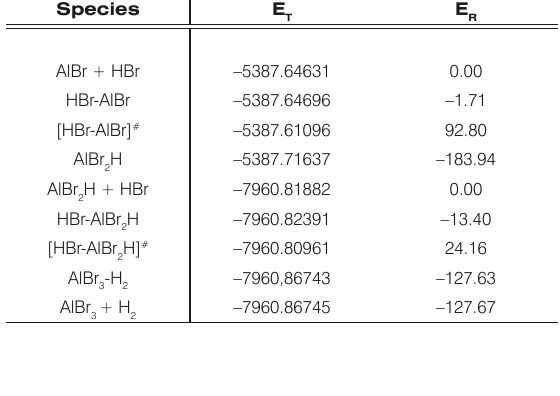
Table 1. CCSD(T)/6-311G(d,p)//B3LYP/6-311G(d,p) + ZPE Total Energies E (a.u.) and relative energies ER (kJ mol -1 ) for T